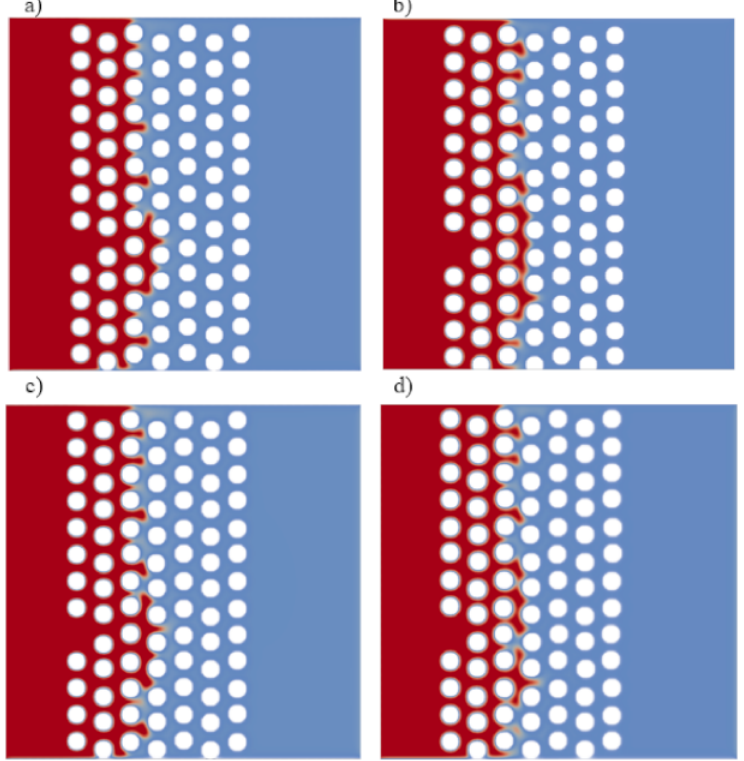
Figure 11. Gaseous phase penetration at t ∗ = 0.225 with fixed C a = 0.038, D = 1, for various contact angles: ( a ) θ = 83 ◦ ; ( b ) θ = 70 ◦ ; ( c ) θ = 50 ◦ ; ( d ) θ = 33 ◦